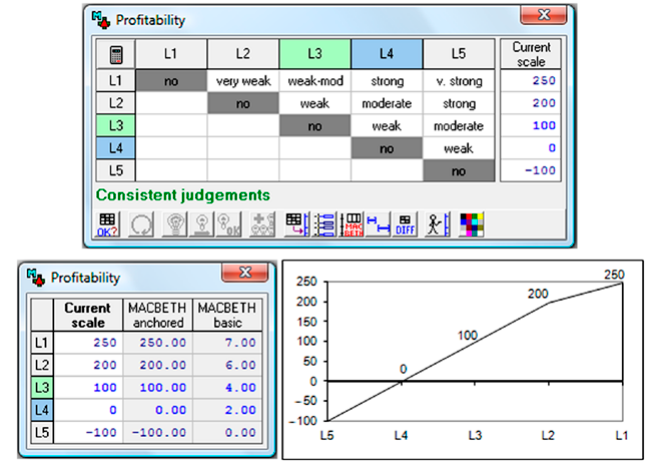
Fig. 3. Value judgments, proposed scales and value function of the FPV